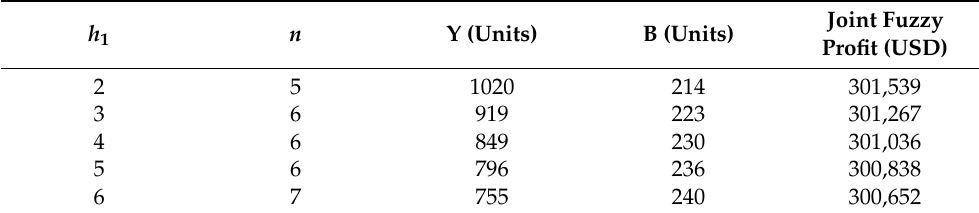
Table 9. Impact of the buyer’s holding cost of the good items on the decision variable and joint fuzzy